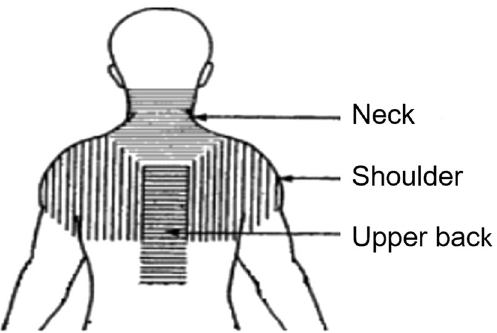
Figure 1. Localization of neck, shoulders and upper back. Reproduced by permission 92